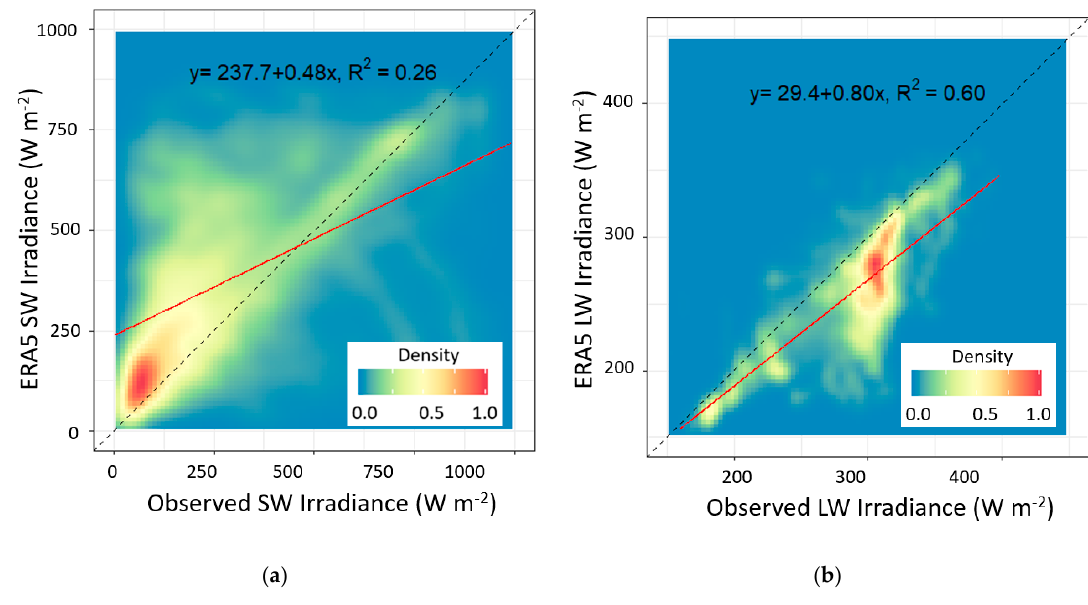
Figure 11. Comparisons of observations from ship-based sensors with ERA5 data interpolated to the location of the ship with occurrence frequency (density) scaled to 0–1 (blue to yellow to red). ( a ) SW irradiance. ( b ) LW irradiance. The scatterplots show linear regression equations and R 2 correlation coefficients between the associated horizontal (x) and vertical (y) ordinates. The regression lines (solid red) and one-to-one line (dashed black) are also shown. Both the observed data and ERA5 data are at 1-min intervals.